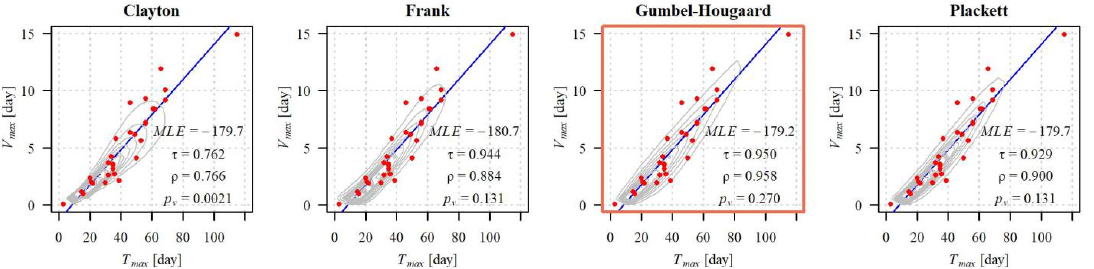
Figure 13. Empirical duration T g max and volume V g max of the maximum droughts (dots) and the density functions of the variable T g max , V g max distributions based on the given copulas in the Żywiec na Soła cross-section. The blue line represents the linear trend line.